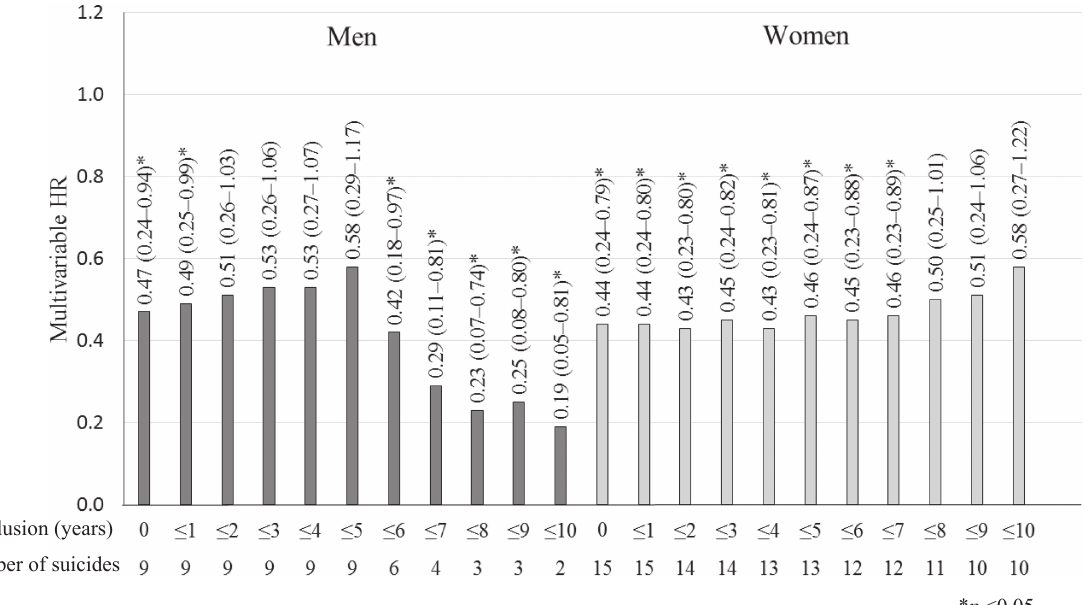
Figure. The sex-speci fi c HRs and 95% CIs of suicide for those with higher education compared to those with junior high school graduates after the exclusion of early suicidal deaths that occurred within 1 to 10 years of the baseline survey. CI, con fi dence interval; HR, hazard